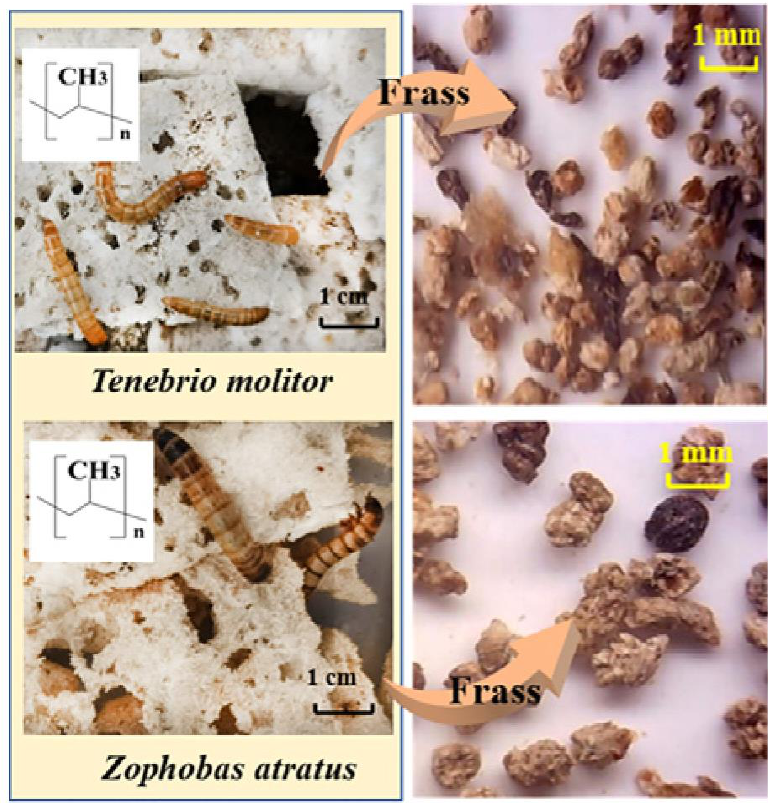
Figure 5. PP foam-eating T. molitor larvae and Z. atratus larvae , reprinted with permission from